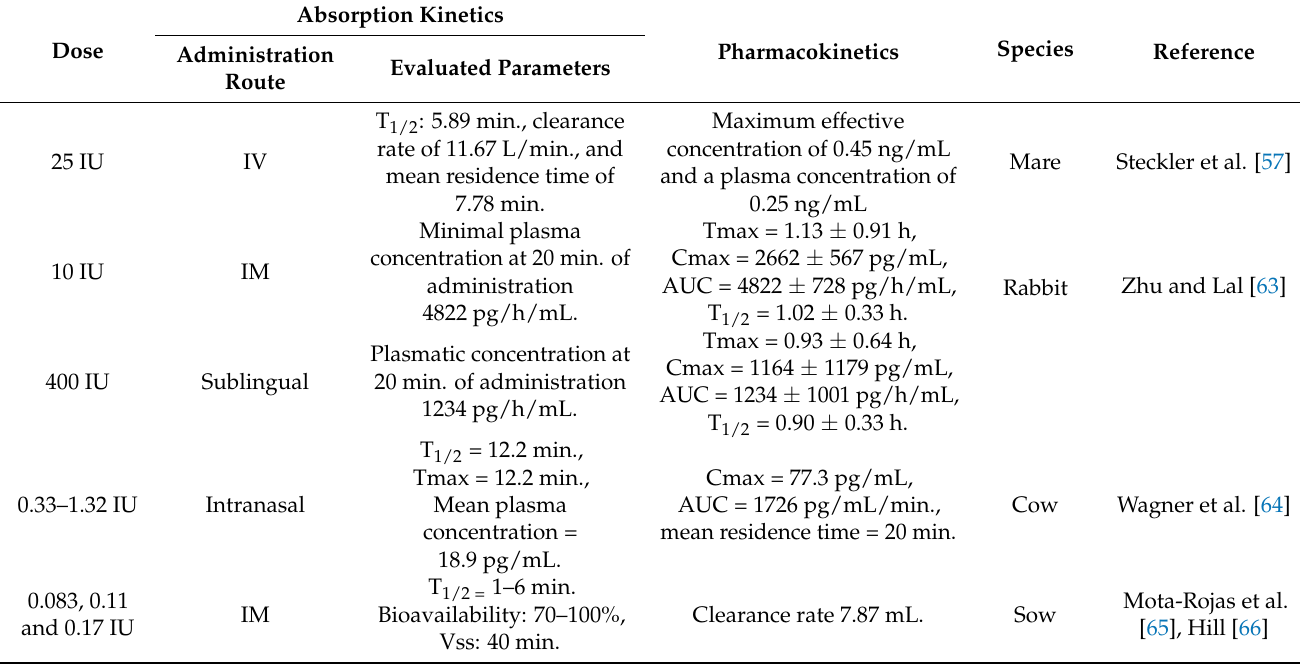
Table 1. Pharmacokinetic parameters of oxytocin in different